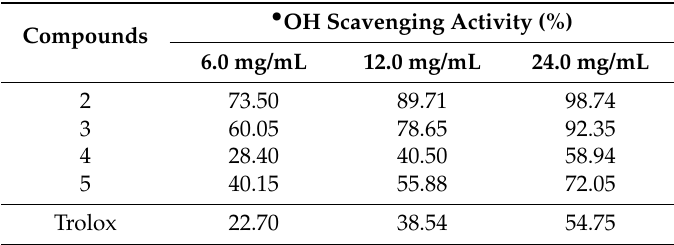
Table 3. Hydroxyl radical scavenging activities of the selected compounds 2 – 5 and trolox.